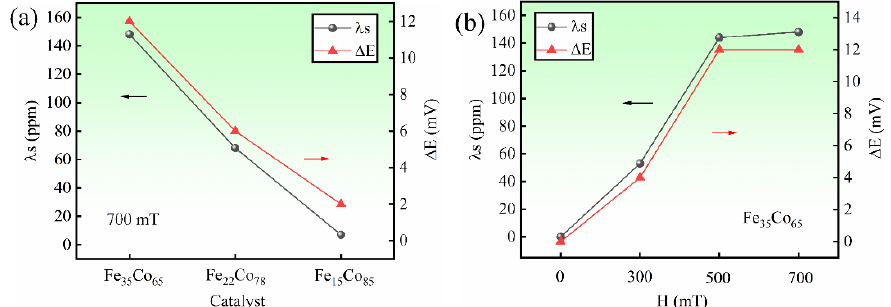
Figure 8. ( a ) Variation diagram of strain and overpotential of Fe 100-x Co x alloys under a magnetic field of 700 mT; ( b ) variation diagram of strain and overpotential of Fe 35 Co 65 alloy under different magnetic field intensities.